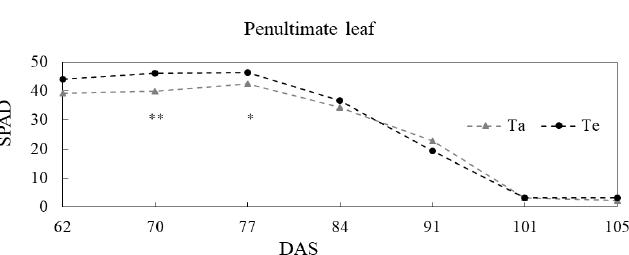
Fig. 3: SPAD values of the penultimate leaf, measured under ambient (T a ) and elevated soil temperature (T e ). SPAD values are averages of five plants of each subplot, used as monitor plants. Asterisks indicate significant differences between plants under ambient and elevated soil temperatures (*P ≤ 0.05; **P ≤ 0.01); n = 4.